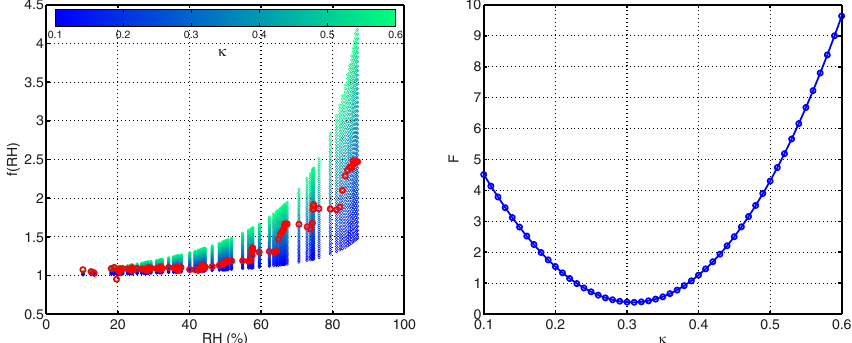
Figure 5. One case of the calculated κ . In the left panel, the red circles stand for the valid f (RH) observations during a humidifying cycle, while the gradient coloured ones represent the corresponding f (RH) calculated with an assumed specific κ . The right panel shows the discriminant coefficient, F , corresponding to each assumed κ